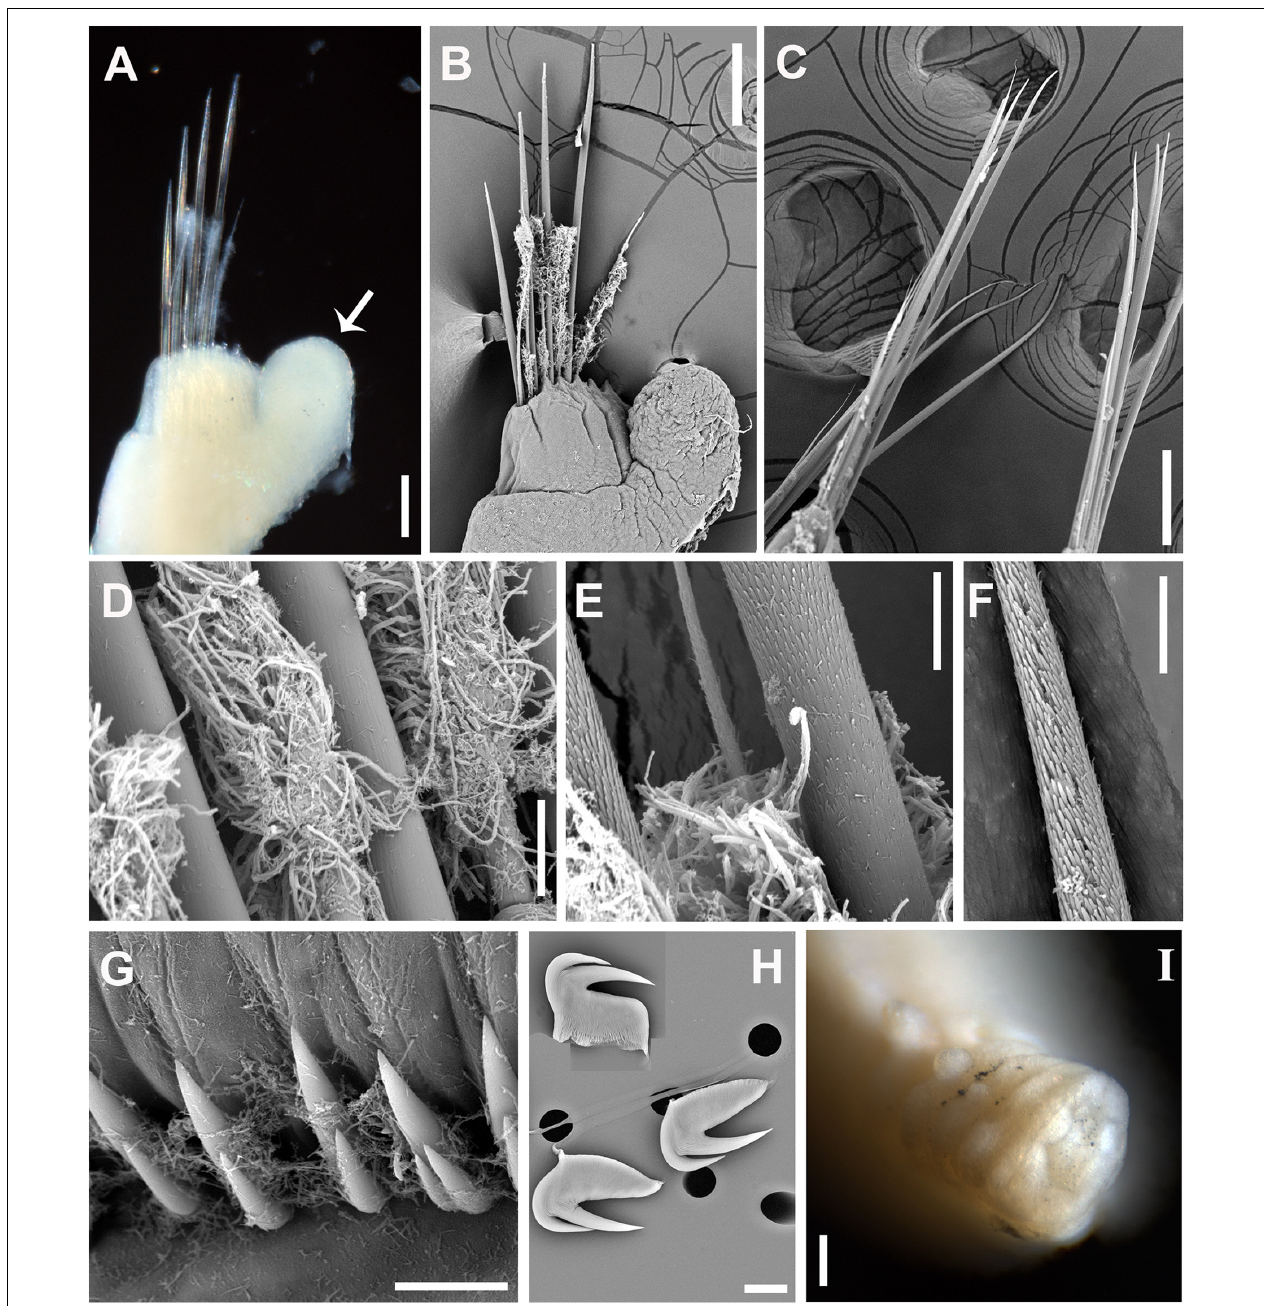
FIGURE 4 | Paralvinella mira n. sp. (A) Notopodia on segment 9, white arrow indicating the digitiform notopodial lobe, anterior view; (B) SEM. Notopodia on segment 9, anterior view; (C) SEM. Notochaetae on segments chaetigers 35–37; (D) SEM. Basal part of notochaetae; (E) SEM. Middle part of notochaetae; (F) SEM. Distal part of notochaetae; (G) SEM. Uncinigerous torus; (H) SEM. Three uncini in details; (I) Pygidium. Scale bar: (A–C,I) , 100 µ m; (D–H) , 10 µ m.